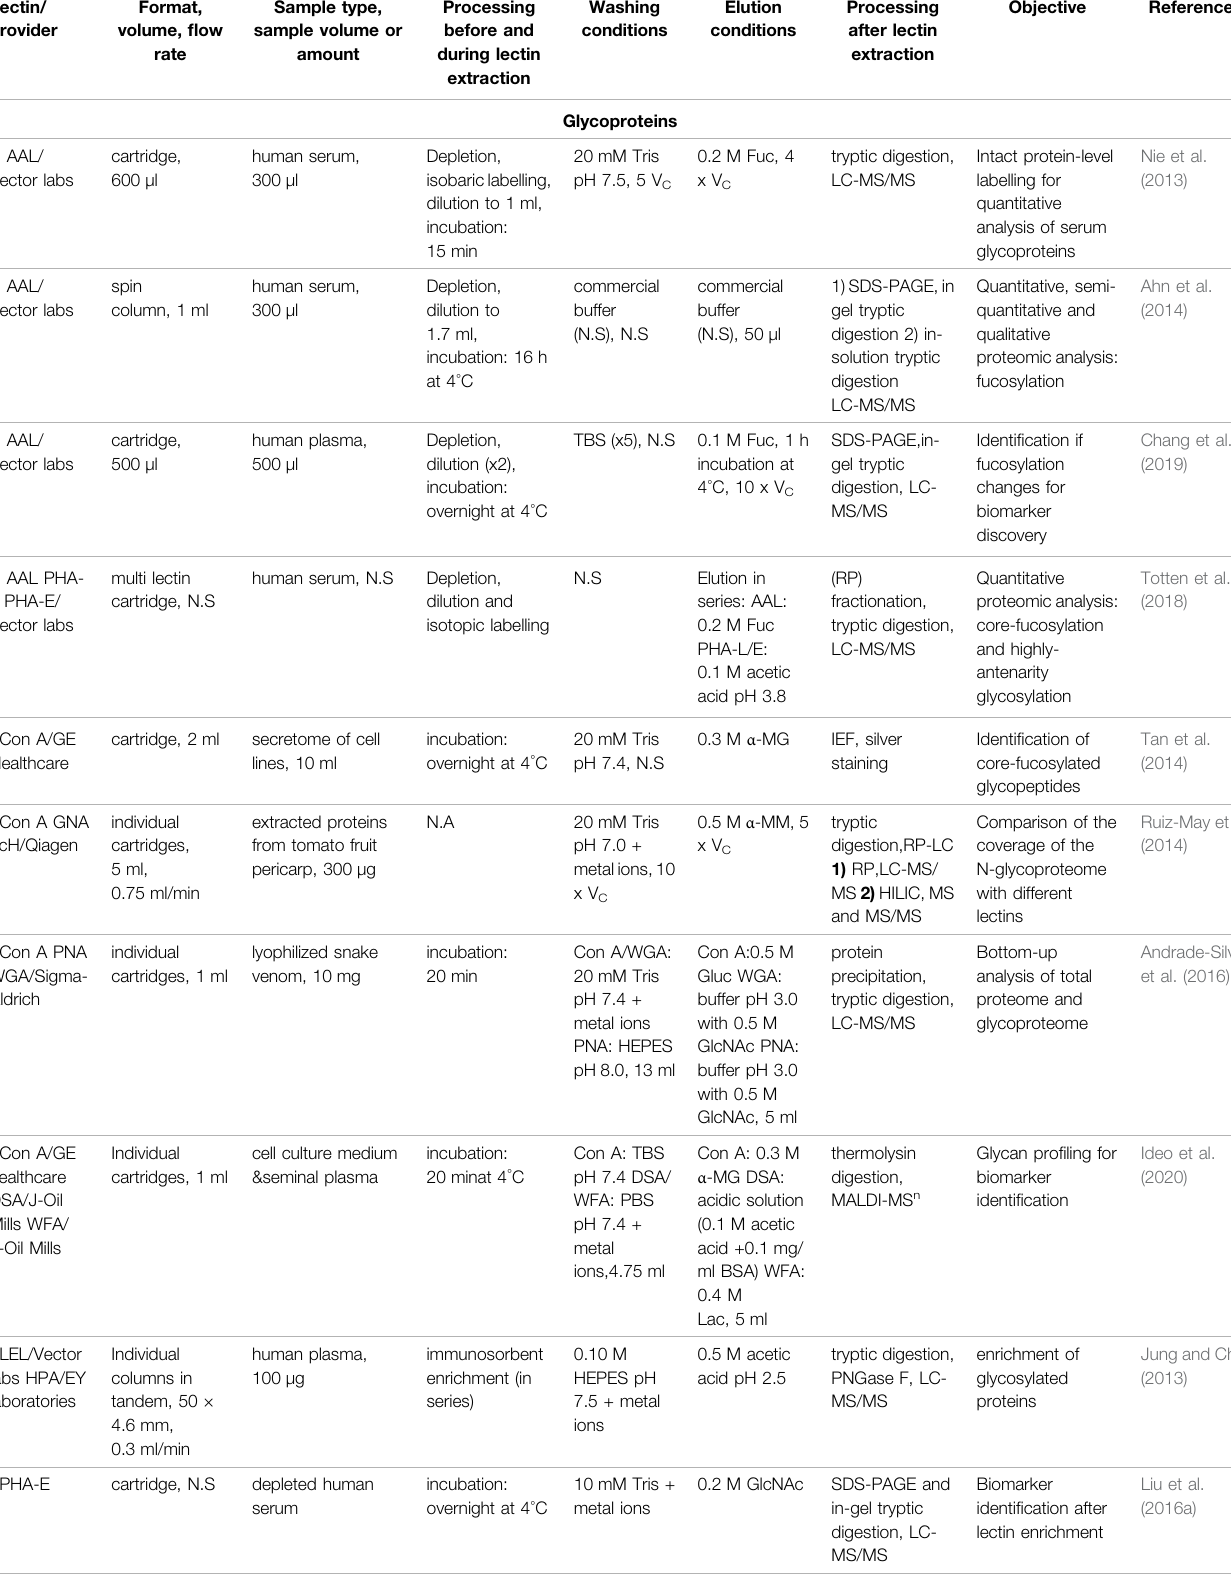
TABLE 2 | Lectin solid phase extraction using commercial